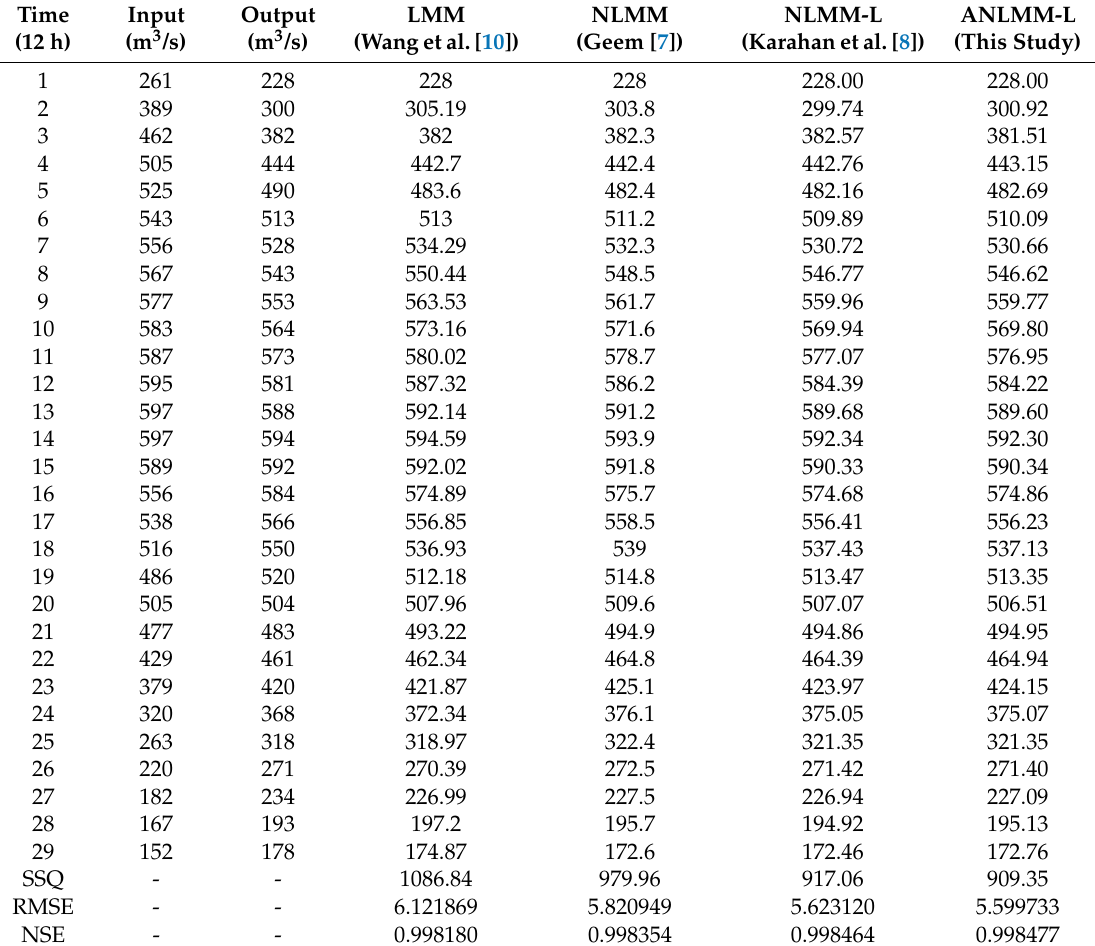
Table 5. Comparison of the outflow hydrographs calculated for Wang et al.’s flood data